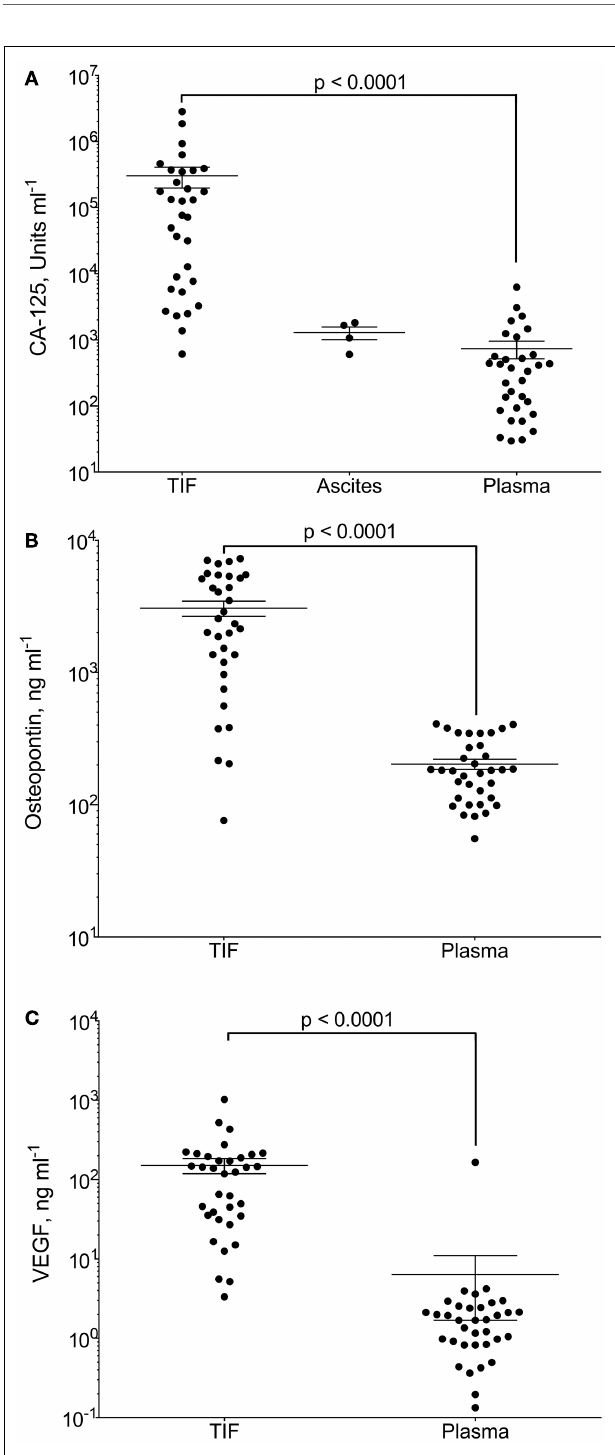
FIGURE 2 | CA-125, osteopontin and VEGF-A in tumor interstitial fluid (TIF), ascites, and plasma . Concentration of (A) CA-125 (Uml (cid:0) 1 ); (B) osteopontin (ngml (cid:0) 1 ); and (C) VEGF-A (ngml (cid:0) 1 ) in TIF, ascites (for CA-125), and plasma from patients with epithelial ovarian carcinomas. Values are for individual tumors and also show mean (cid:6) SEM. *** p = 0.0001 (Wilcoxon matched pairs signed rank test). Reproduced from Haslene-Hox et al.(98) with